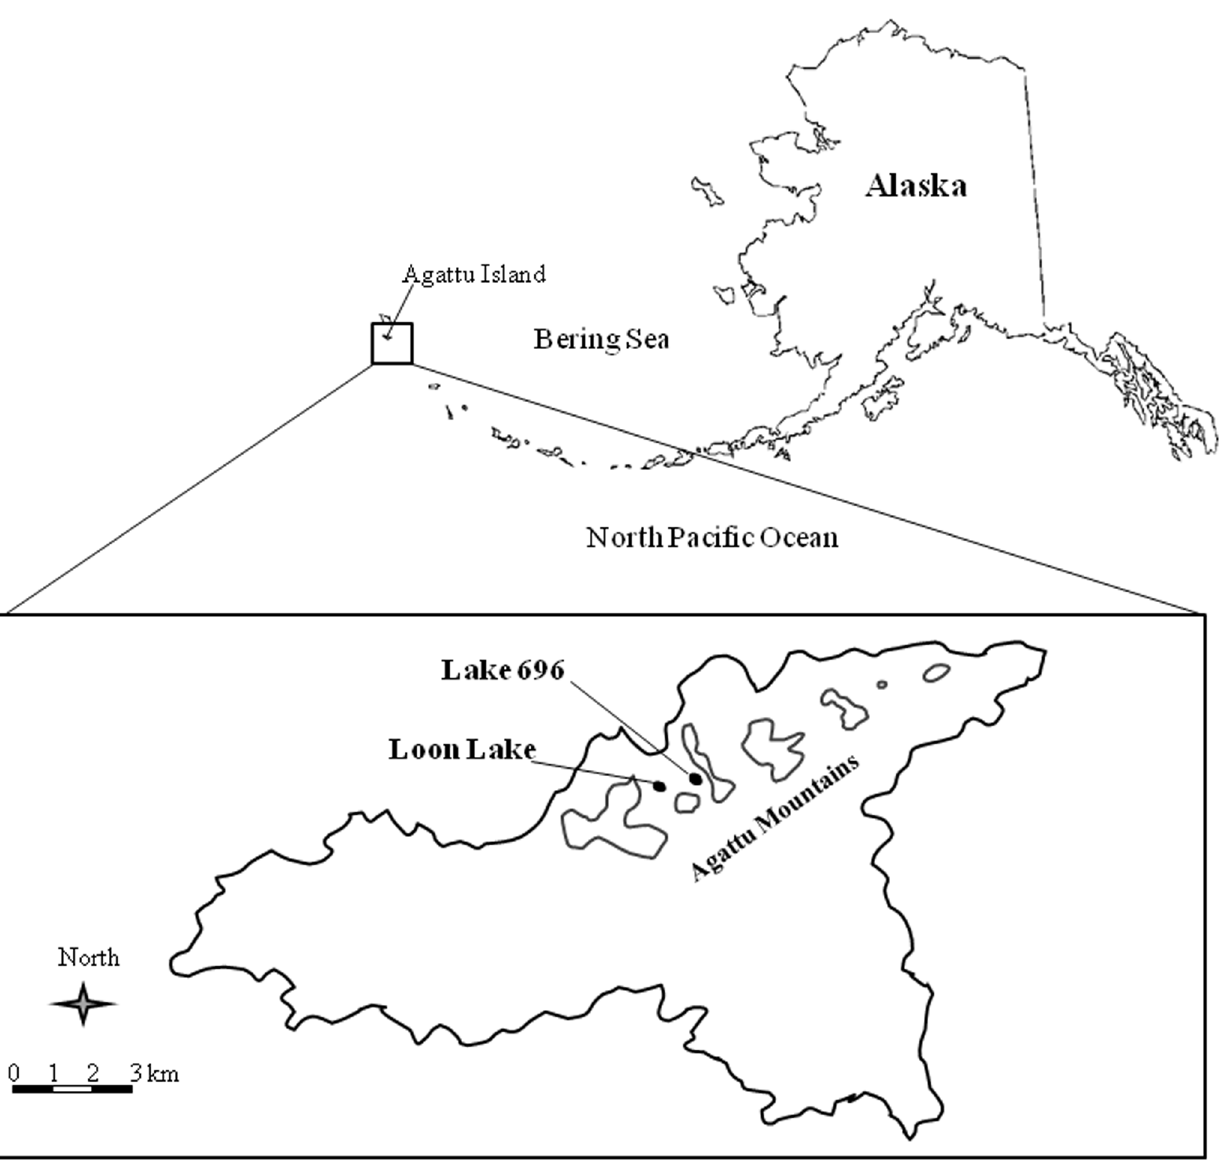
Figure 1. Location of study at Agattu Island in the Aleutian Archipelago, Alaska. Outline of Agattu Mountains is indicated by 300 m contour line.